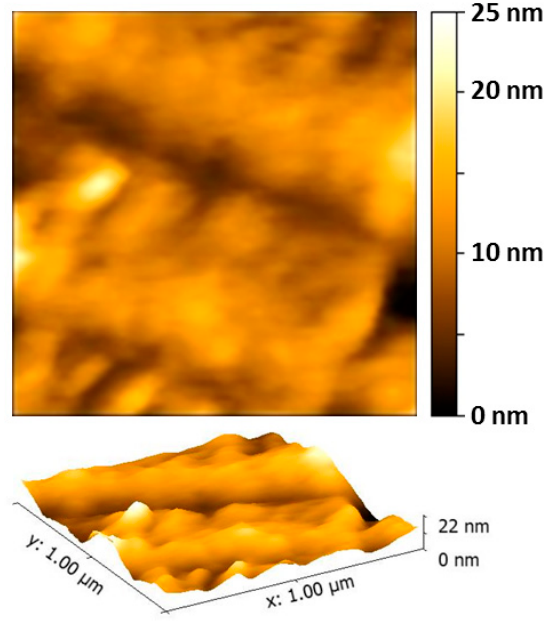
Figure 7. 2D and 3D AFM images in fluid of the 2.5 μ m × 2.5 μ m area of the Au-3MPS@sPEEK membrane.